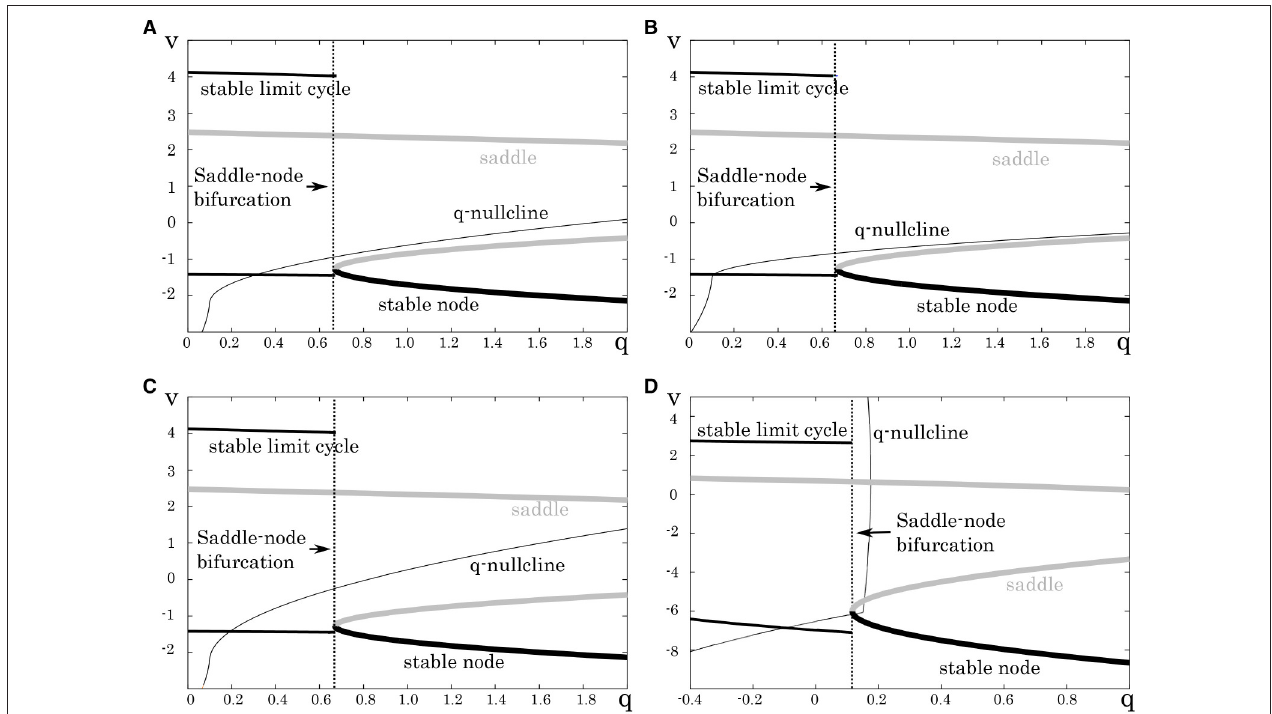
FIGURE 5 | Mathematical structures of the DSSN models. Projected mathematical structures onto the q - v plane. A stimulus sufficiently strong for periodic spiking is applied. A saddle-node on invariant circle bifurcation is seen in (A) the excitatory RS, (B) inhibitory RS, (C) FS, and (D)